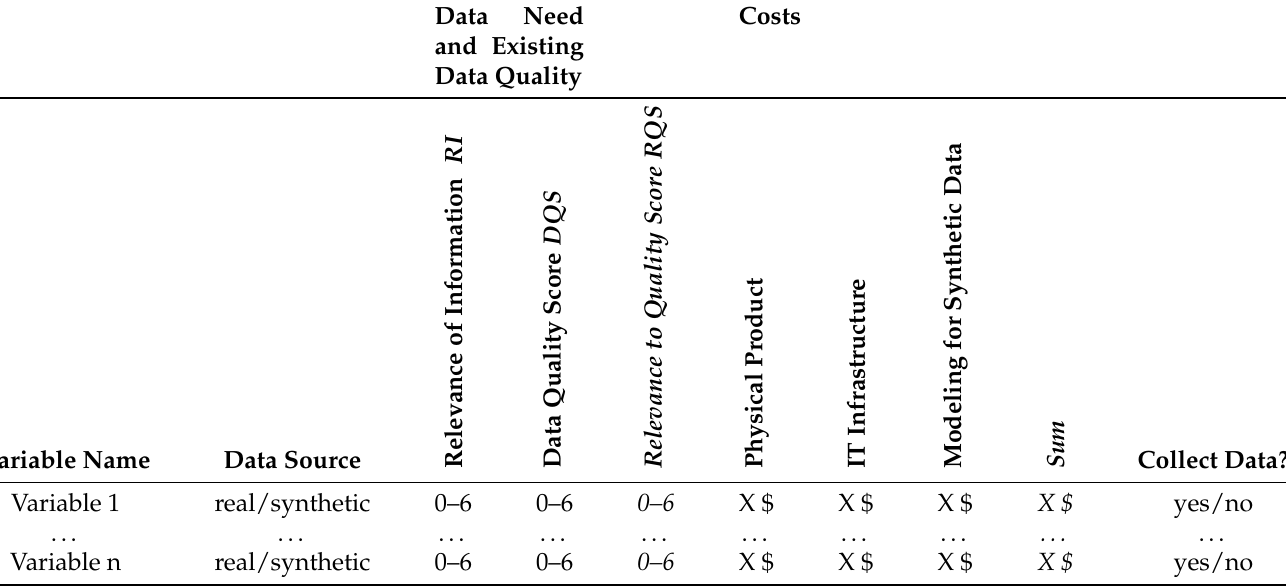
Table 3. Data decision